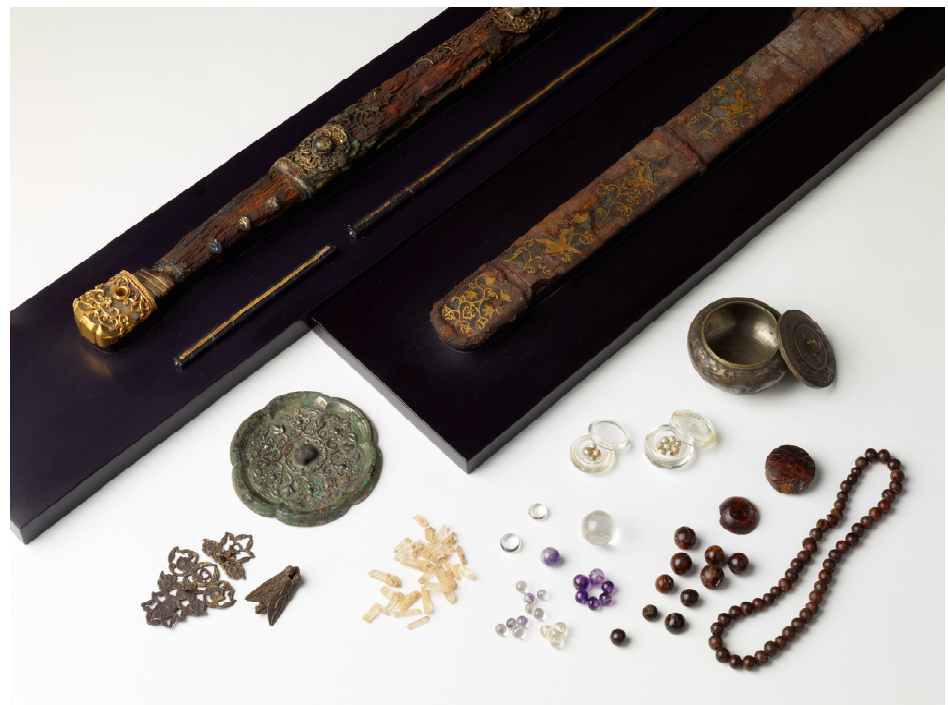
Figure 3. Sample of objects unearthed from beneath the Seated Vairocana Buddha. “Great Buddha Hall” (Daibutsuden), T ō daiji, Nara prefecture. Nara period, latter half of 8th century. In the collec- tion of T ō daiji. Image: Nara National Museum.